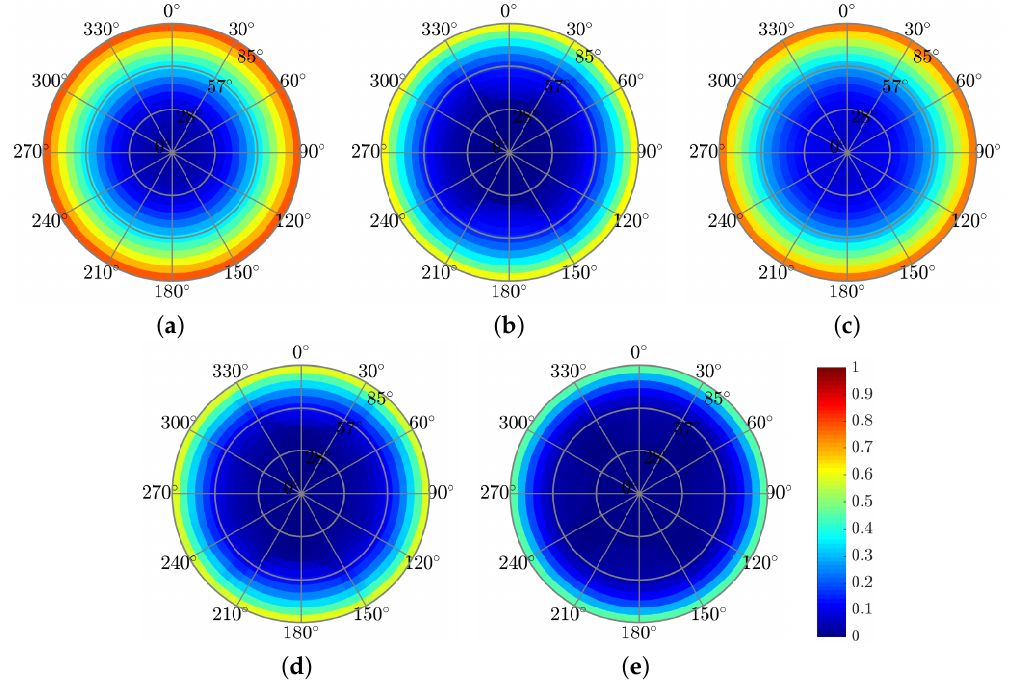
Figure 11. Reflection color maps showing dependence on the polar ( θ ◦ -radius) and azimuthal ( φ ◦ -angle) incident angles at λ = 600 nm. ( a ) Reference solar cell. ( b ) Structure A. ( c ) Structure B. ( d ) Structure C. ( e ) Pyramid A